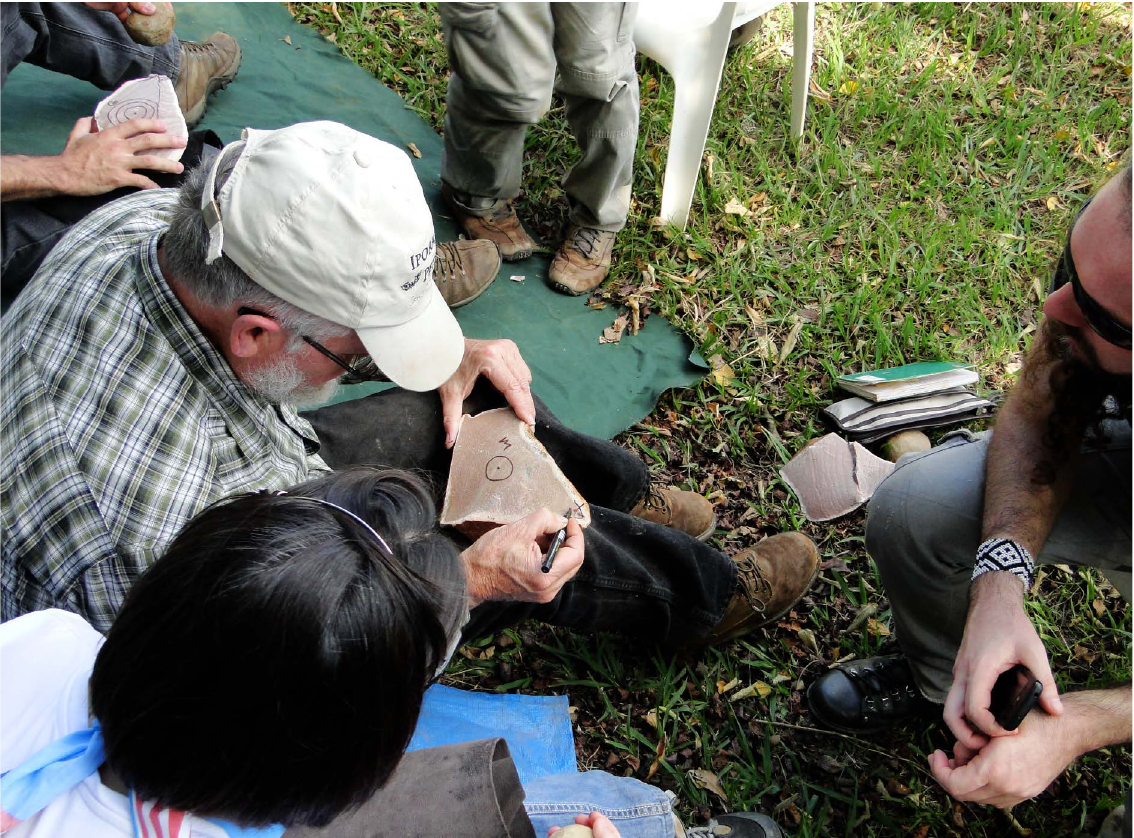
Figure 2. Bruce Bradley explaining the first task and technique. (Photograph by Astolfo G. M. Araujo,